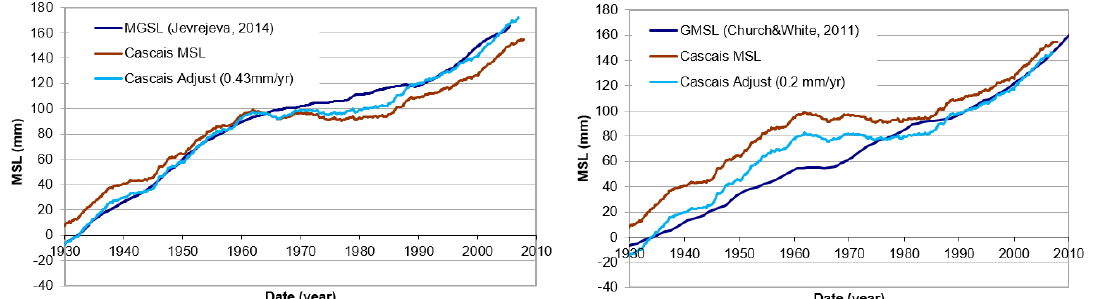
Figure 6. MSL of Cascais (in mm), modeled by a 20-years moving average of the secular series (Figure 2), adjusted to the GMSL from [9] by a rate of 0.43 mm/year (left graph) and fitted to the GMSL from [10] by a rate of 0.2 mm/year (right graph), both with rotation points at epoch 2000 and an adequate vertical shift to overlay the curves.